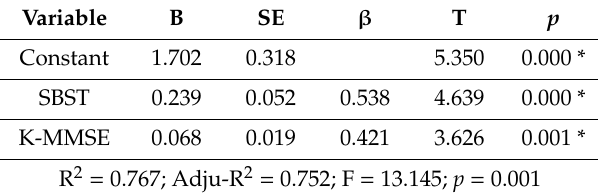
Table 4. Stepwise multiple regression basic neurologic cognition and social cognition on ACLS.